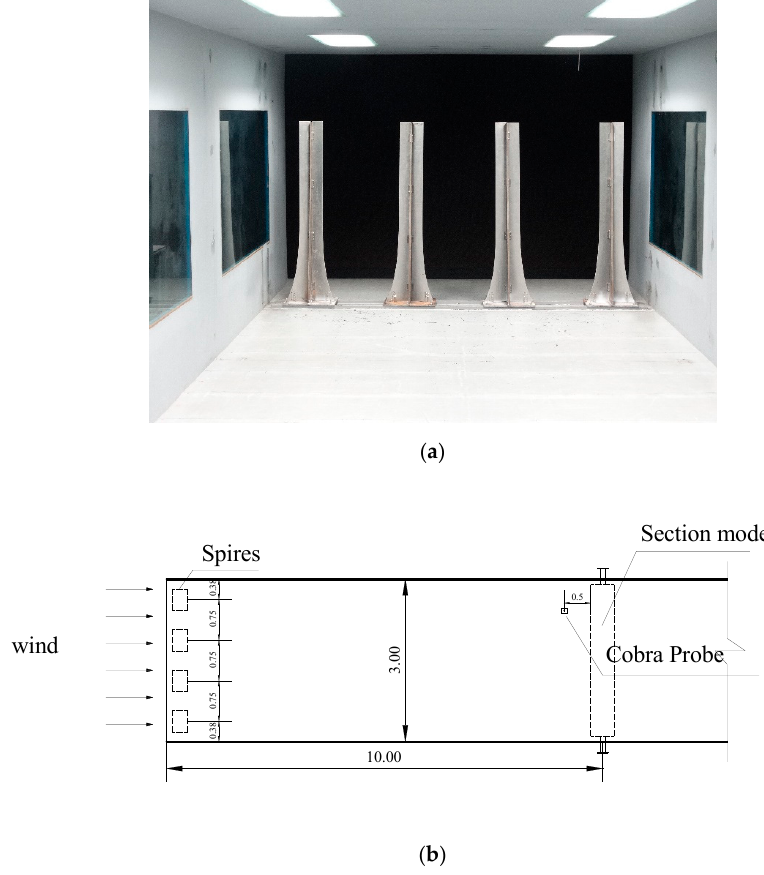
Figure 4. Experimental setups of turbulent flows (m): ( a ) spires in the wind tunnel; ( b ) set of spires (unit: m).